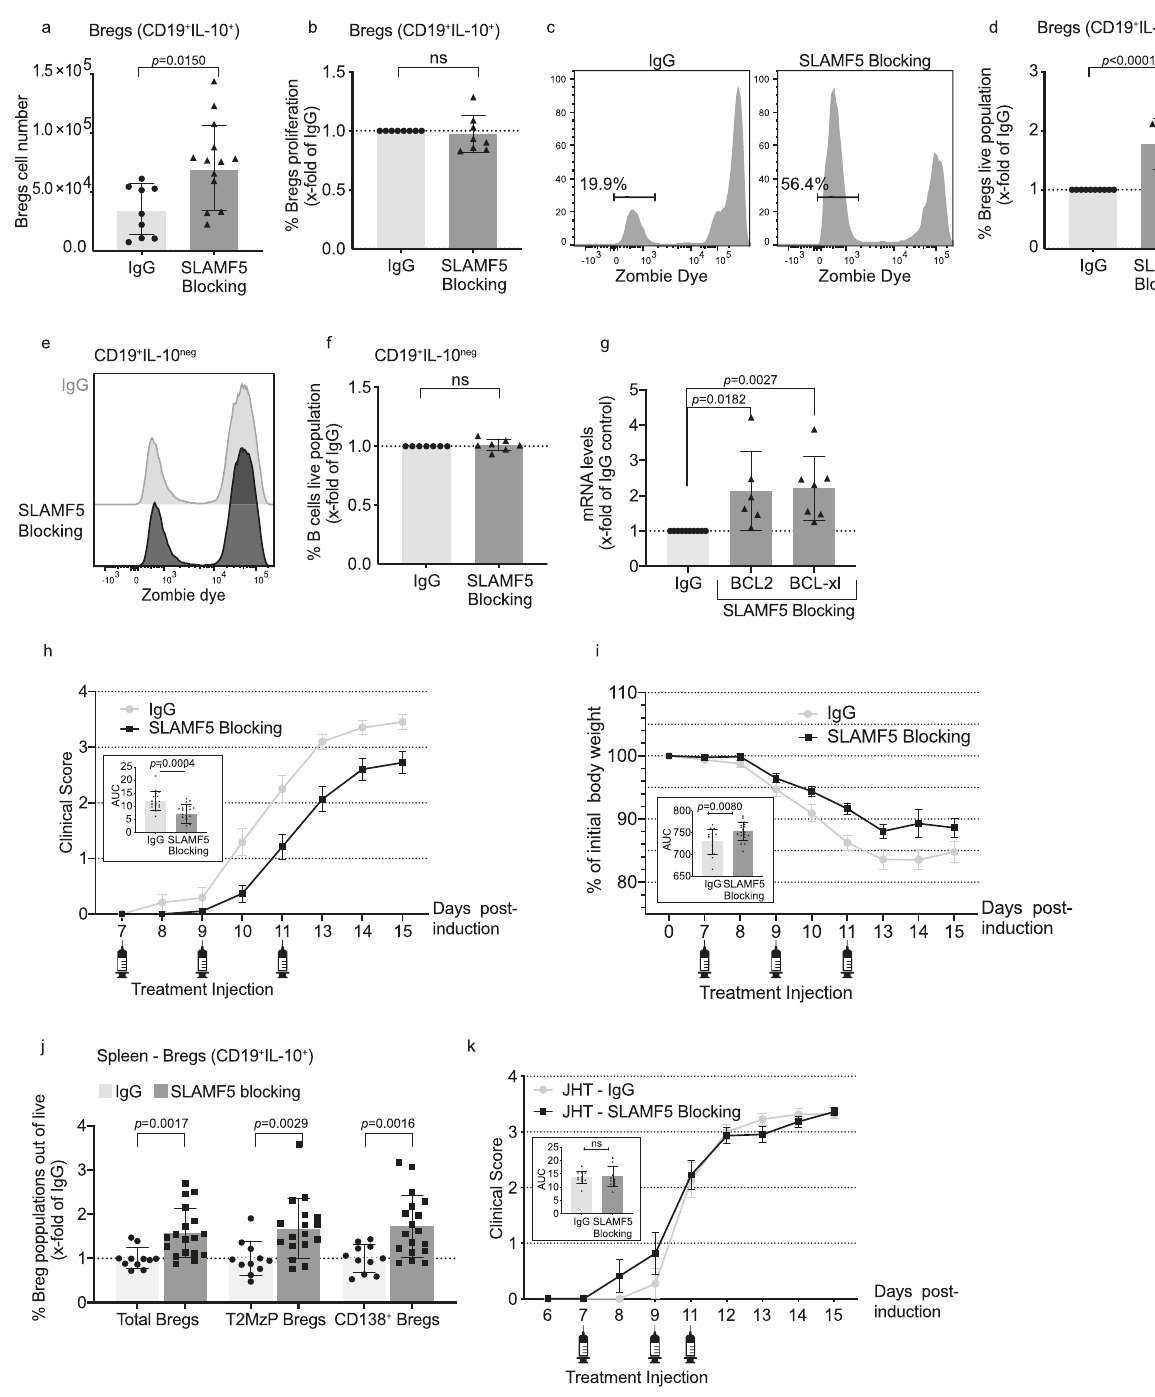
healthy mice (Supplementary Fig. 8c) upregulated the levels of total Bregs and the Breg subpopulations T2MzP and CD138 + (Fig. 4j), suggesting that SLAMF5-blocking downregulates Breg numbers in health and